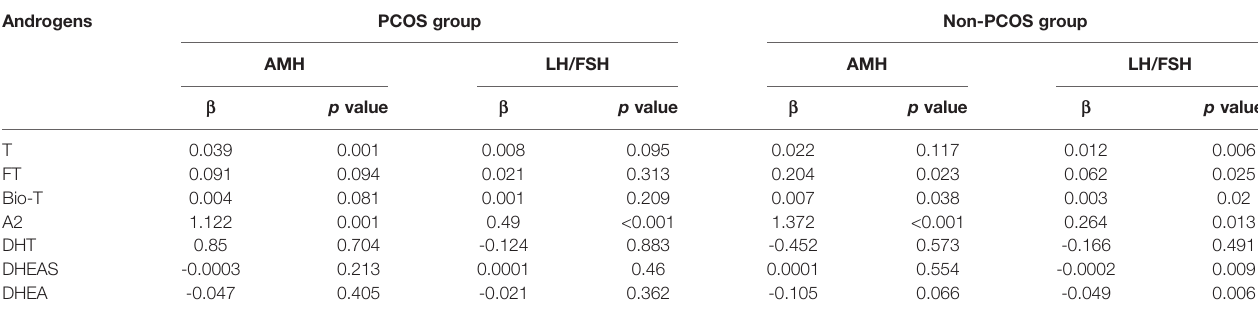
TABLE 2 | Multivariate linear regression studies between androgens and AMH or LH/FSH.